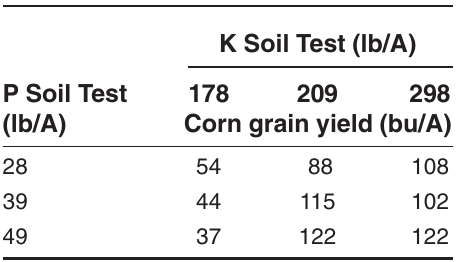
Corn Response to Different Soil Test Levels in a Corn-Soybean